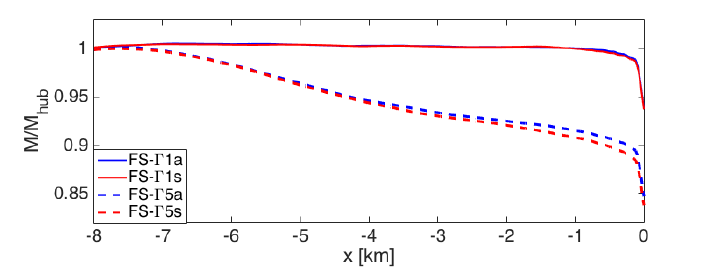
Figure 5. Time- and spanwise-averaged velocity magnitude at the hub height in the wind farm induction region, normalized by the inflow velocity magnitude at hub